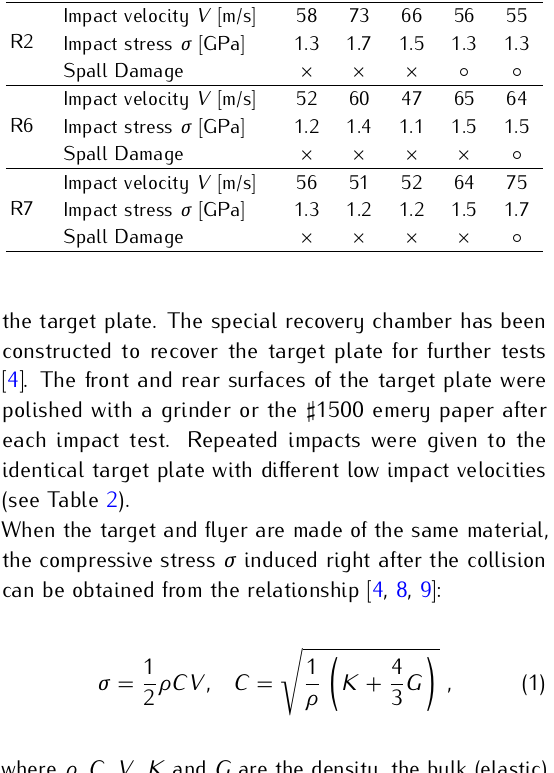
Table 2. The detailed listing of the test conditions carried out on medium carbon steel specimens and the occurrence of spall damageaftertheeachimpactdetectedbySLFAM-technique. The symbols O and × stand for distinguished and non- iden- tified spall damage, respectively. Specimen No.